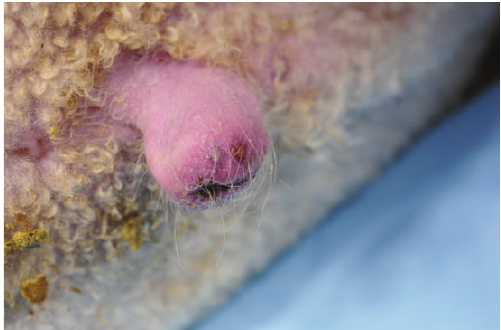
Figure 1: Left lips and philtrum. Multifocal-to-coalescing necrotiz- ing and proliferative cheilitis and dermatitis.